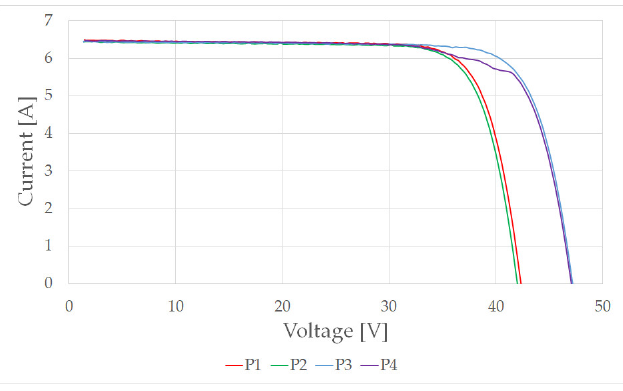
Figure 4. I-V characteristics